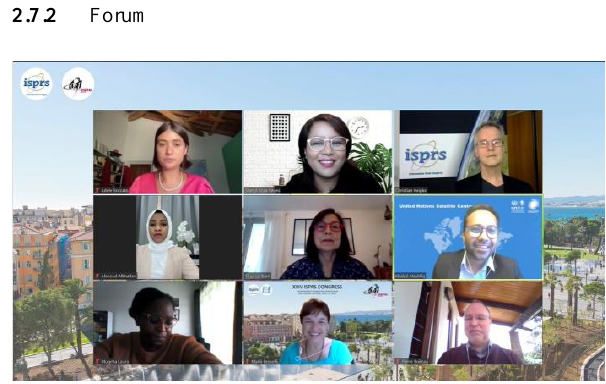
Figure 3. Our special guests for the panel discussion in the forum, which was moderated by the ISPRS SC President, together with Adele Roccato of UNEP.